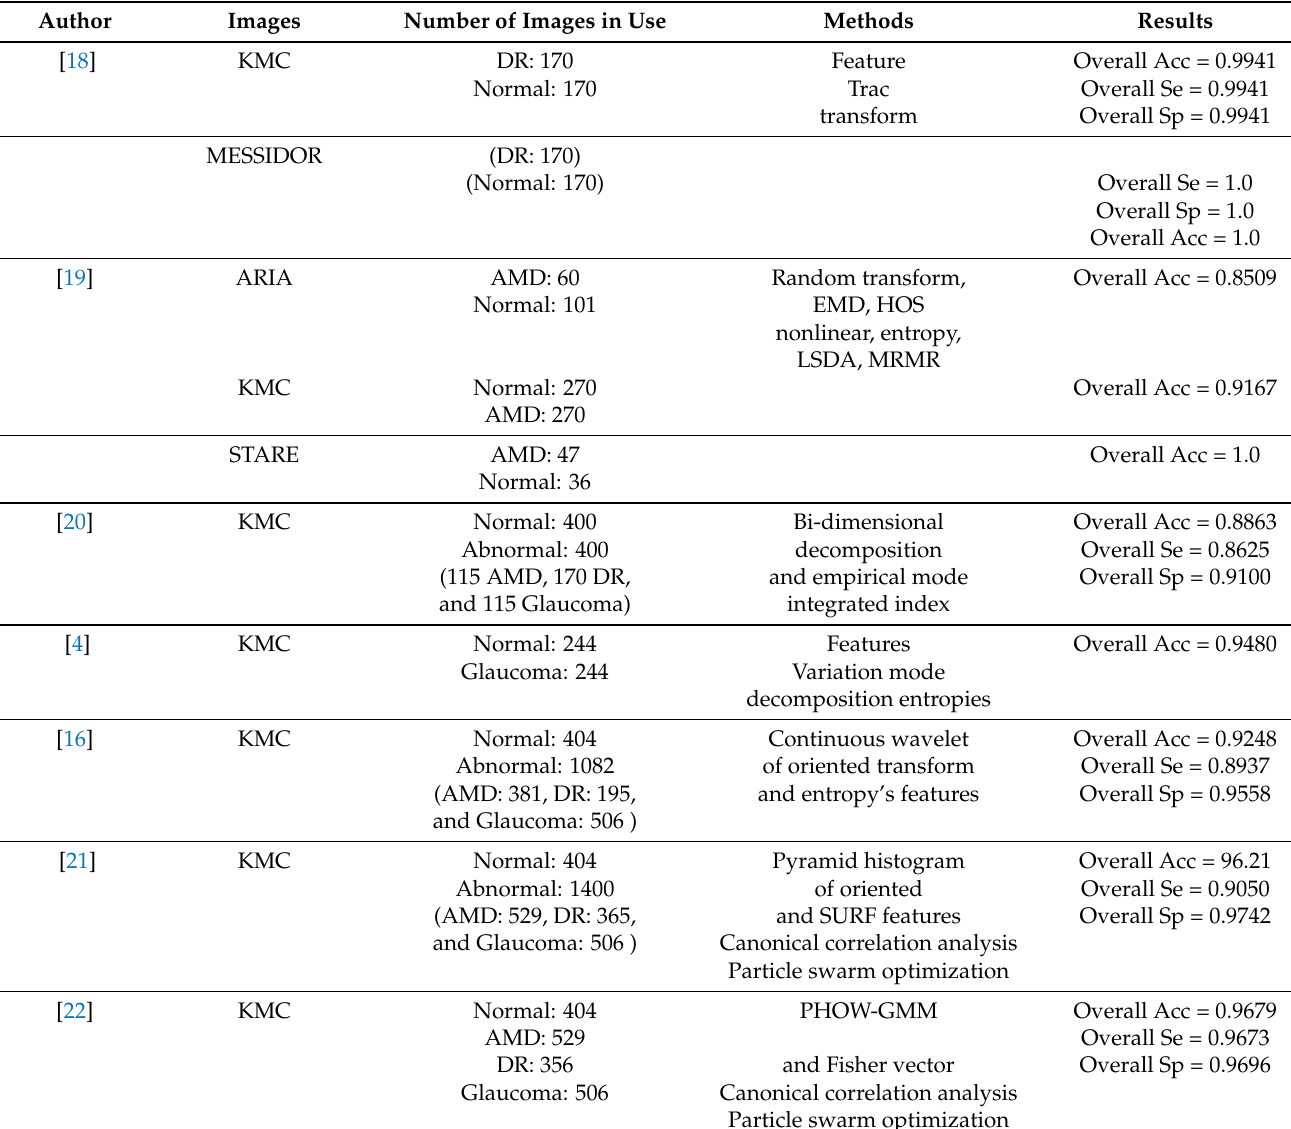
Table 1. Selected methods for retinal CAD systems through retinal fundus